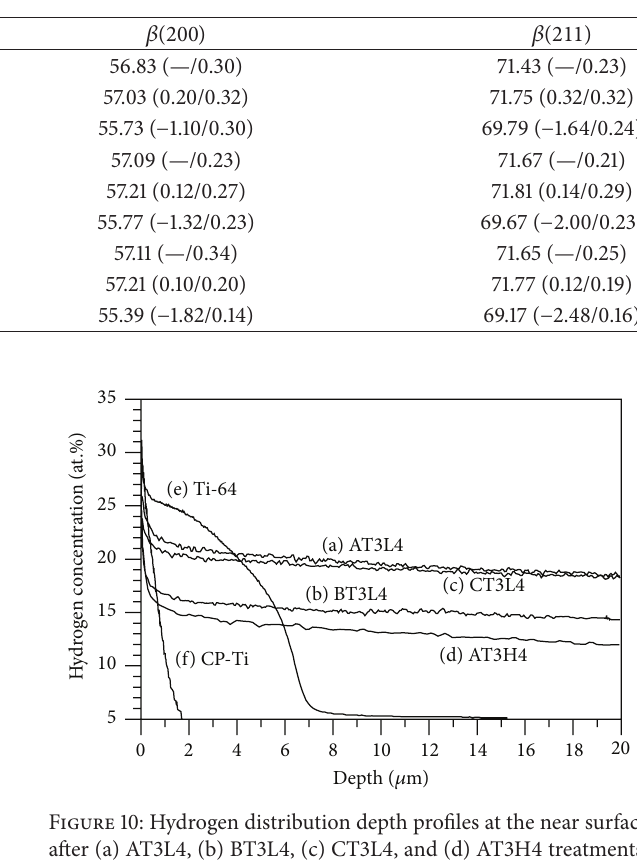
Table 4: The magnitude of angular shift and (/) the FWHM in degree of peaks 𝛽(110) , 𝛽(200) , and 𝛽(211) for some treated specimens corresponding to A0, B0, and C0 ones, respectively.